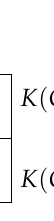
Figure 8. Two-part state codes for FSM